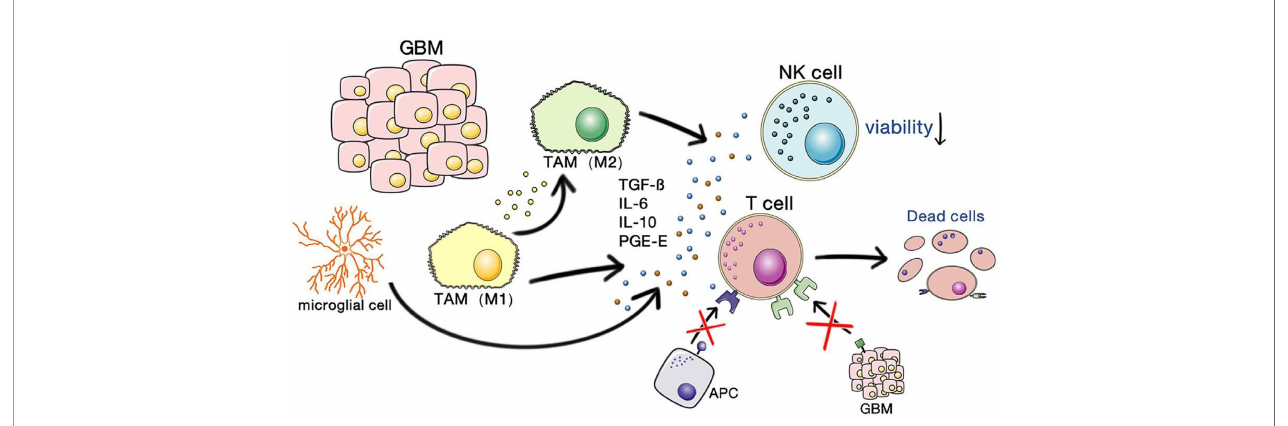
FIGURE 1 | The immunosuppressive microenvironment of GBM.